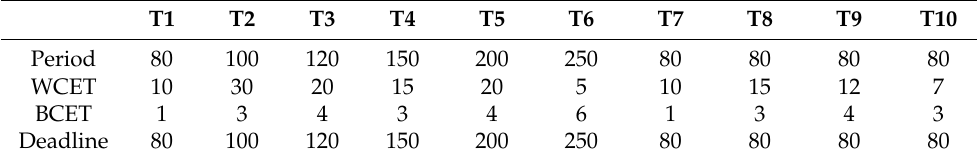
Table 3. Example of System Timing Requirements (ms), where n = 10 tasks m = 5 (CPU). T1